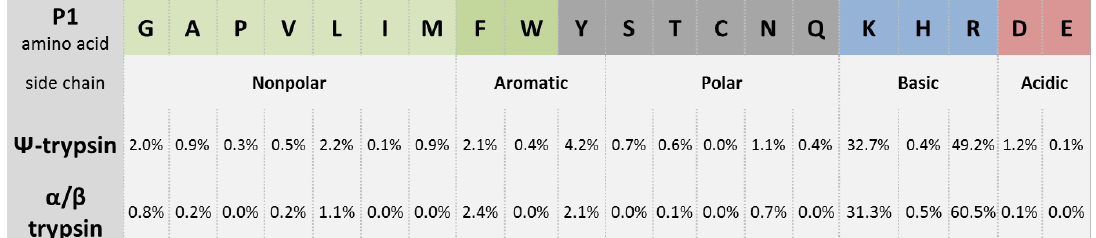
Figure 4. C-terminal amino acids (P1 cleavage site) of peptides in ψ-tryptic and tryptic digests. This table summarizes results obtained after in-gel digestions of barley nuclear proteins. The percentage values were averaged from data for almost 40 distinct protein fraction samples. MALDI TOF/TOF